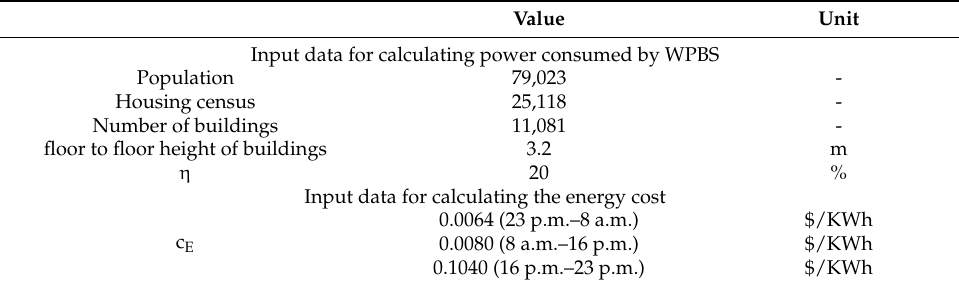
Table 4. Basic information on the energy sector model.